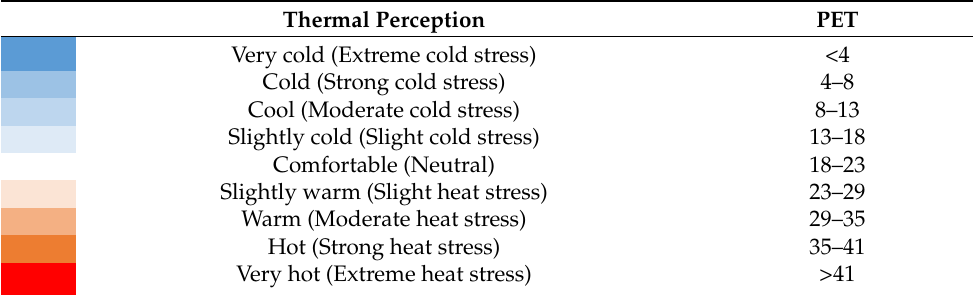
Table 1. Categorization PET level for different thermal